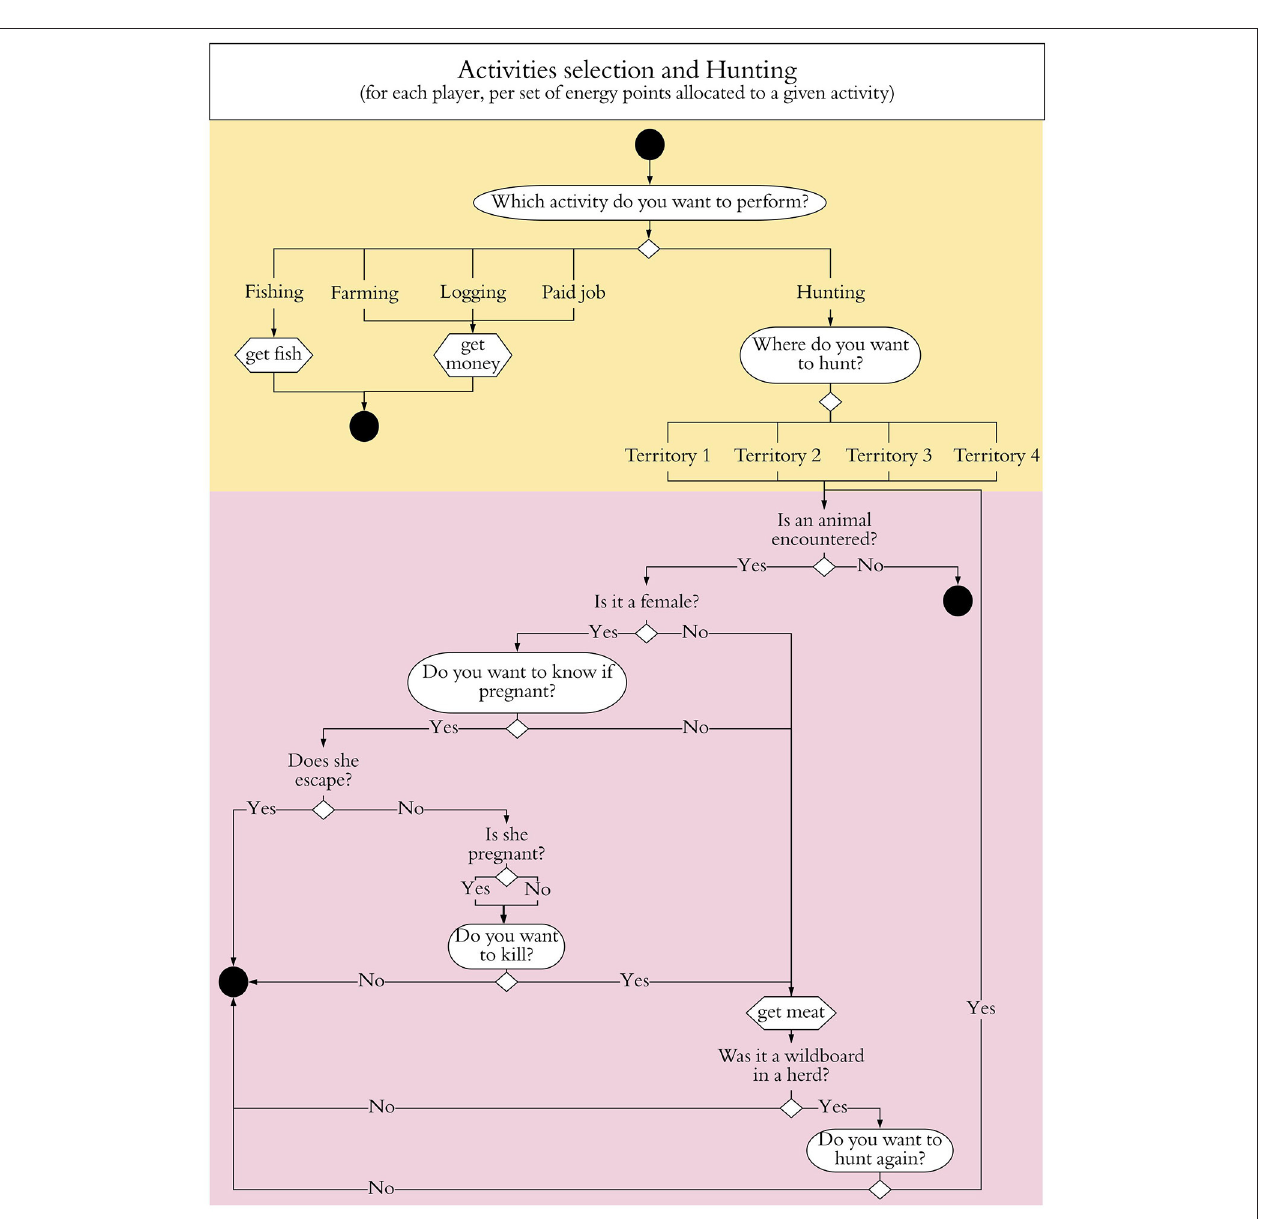
FIGURE 4 | Schematic representation of the game dynamics. The colors correspond to different phases of the game: the allocation of energy to different activities (in yellow) and hunting (in pink). The white round containers indicate questions posed to the players, the hexagonal ones are the game’s outcomes.